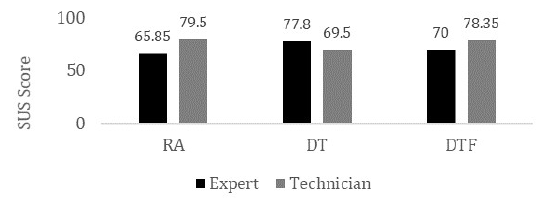
Figure13. Summary of SUS